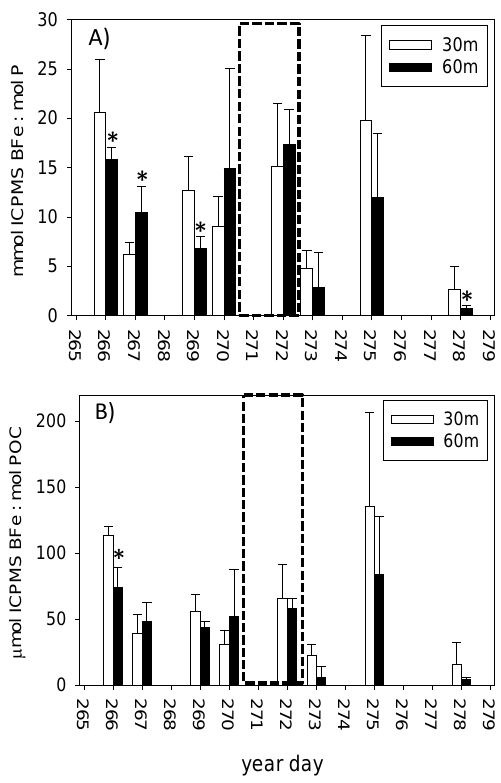
Fig. 3. Oxalate-washed ICPMS-based BFe:P and BFe:POC ratios at 30m and 60m over the course of the study. (A) mmolBFe:molP and (B) µmolBFe:molPOC. For each day, left bar (white)=30m, right bar (black)=60m. The transition between the two phases of the study is marked by the dashed line rectangle. Error bars repre- sent 1 standard deviation ( n = 3). Significant differences between 30 and 60m is designated by an asterisk ( p < 0 .